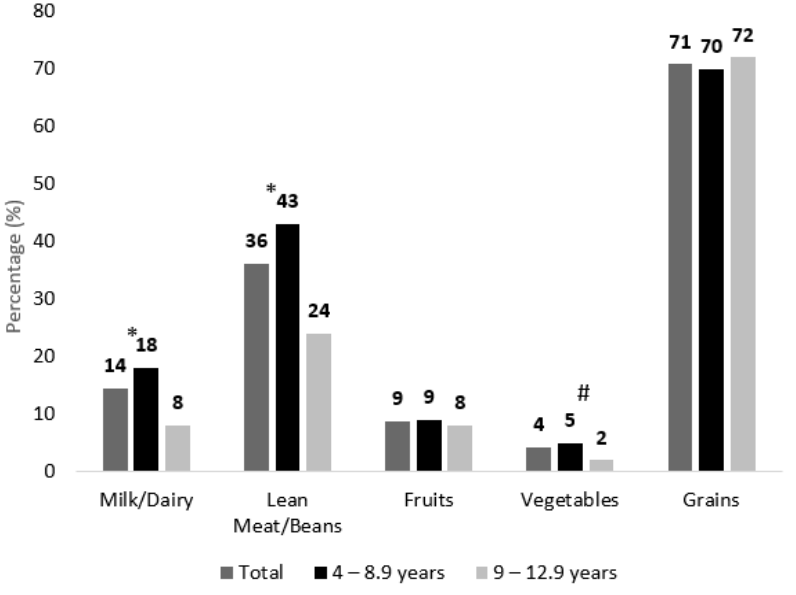
Figure 3. Adherence to AHA/AAP Dietary Recommendations amongst UAE Children aged 4–12.9 years (%), KNHS 2021. * Indicates significant difference ( p < 0.05) between the 4–8.9 and the 9–12.9 years age groups. # Indicates a p -value of 0.052 (trend) between the 4–8.9 and the 9–12.9 years age groups.